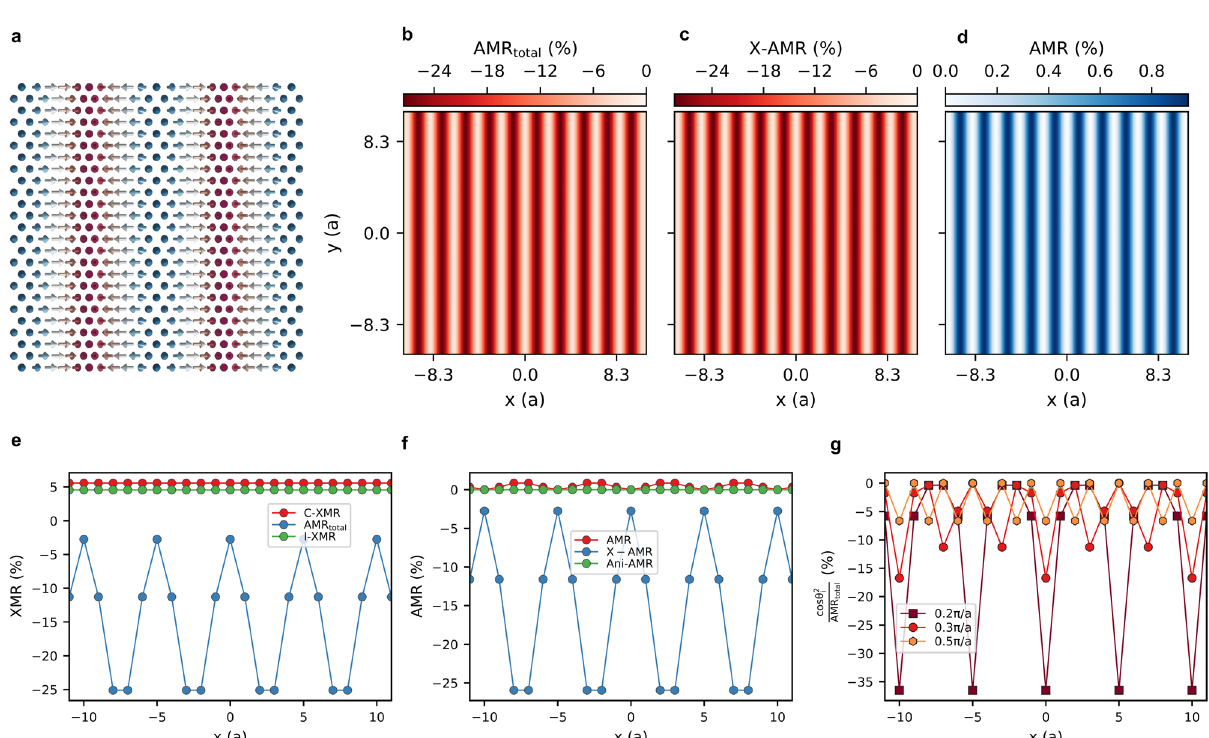
Fig. 3 Magnetoresistance patterns characterizing spin-spirals. a Spin-spiral with wave vector q = 0.2 π /a along the [100] direction, with a being the ffiffiffi p inplane lattice constant of Ir(111), i.e., a ¼ a bulk = 2 where a bulk = 3.83 Å, and associated AMR signals: b total AMR, c X-AMR, and d conventional AMR considering the MR weights obtained at a bias energy of eV bias = 0.56 eV. A systematic comparison of the different XMR components along the x -direction is provided in ( e , f ). The ratio cos 2 θ i = AMRtotal is shown in ( g ) for spirals of wave vectors 0.2 π /a, 0.3 π /a, and 0.5 π /a to visualize the contribution of the new